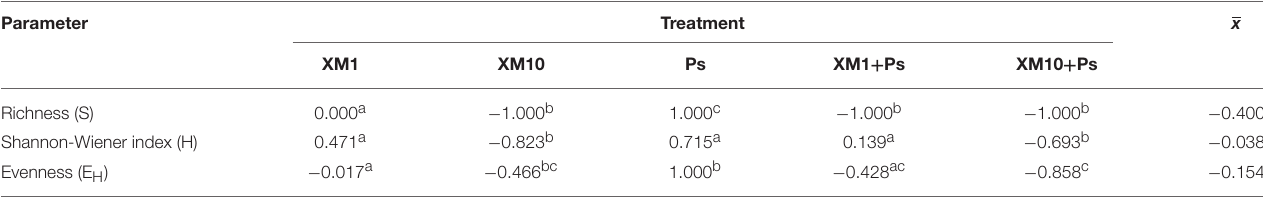
TABLE 5 | Values of the resilience (RL) index for the measured parameters obtained at the end of the experiment. Parameter